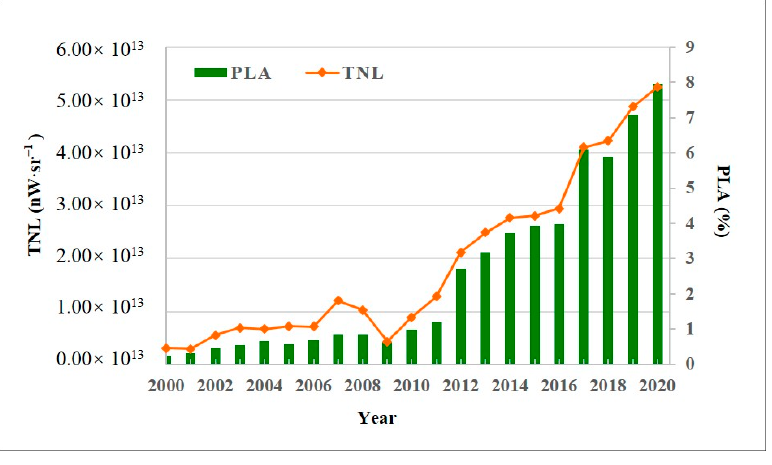
Figure 3. TNL and PLA within the ECR of Zhejiang Province from 2000 to 2020. The MNL was constructed to compare the ALAN change rate between different